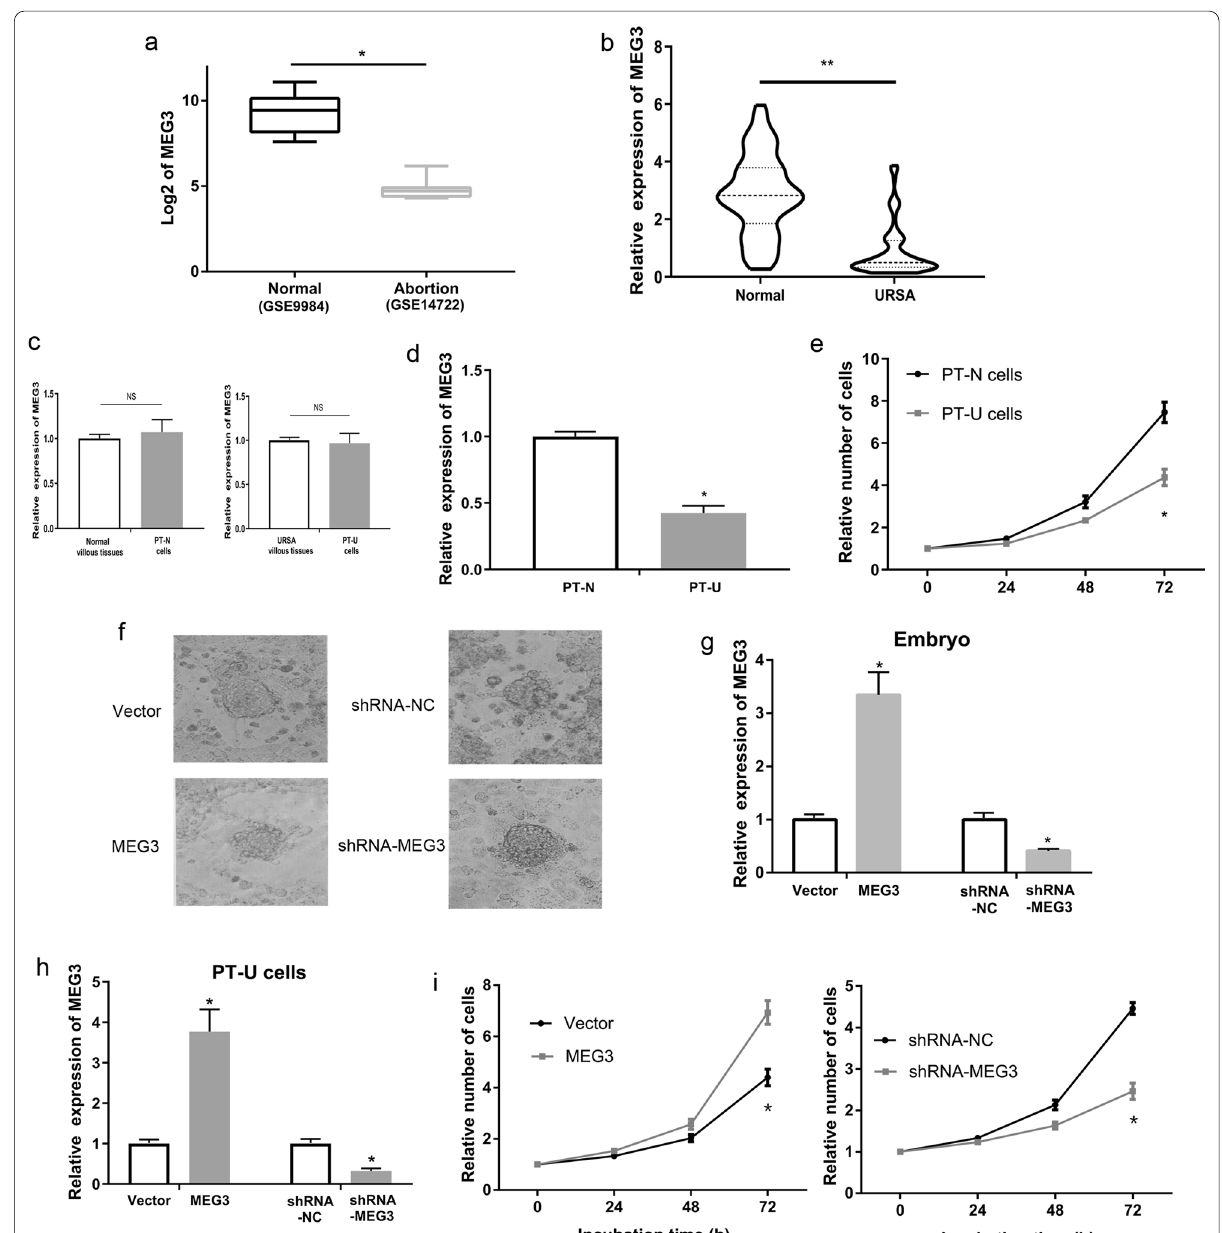
Fig. 1 The expression and function of MEG3 in trophoblast of URSA. a Analysis of RNA expression profile using the GSE14722 data (RNA-seq data of embryonic villi from 11 abortion patients) and GSE9984 data (RNA-seq data of embryonic villi from 12 normal pregnant women). b The expression levels of MEG3 in embryonic villi from URSA patients and normal tissues using qRT-PCR assays. c Compare the expression of MEG3 in villi from URSA patients and PT-U cells (Primary trophoblast of URSA). d Compare the expression of MEG3 in PT-U cells and PT-N cells (normal primary trophoblast cells). e Compare the proliferative capacity of PT-U cells and PT-N cells. f The effect of MEG3 on the implantation capacity of mouse embryo in vitro. g The expression of MEG3 in MEG3 and shRNA-MEG3 transfected mouse embryo using qRT-PCR assays. h Effects of plasmids harboring MEG3 sequence and shRNA-MEG3 on the expression level of MEG3 in PT-U cells using qRT-PCR. i The effects of MEG3 on the proliferative capacity of PT-U cells using CCK-8 assay. **P < 0.01, *P <